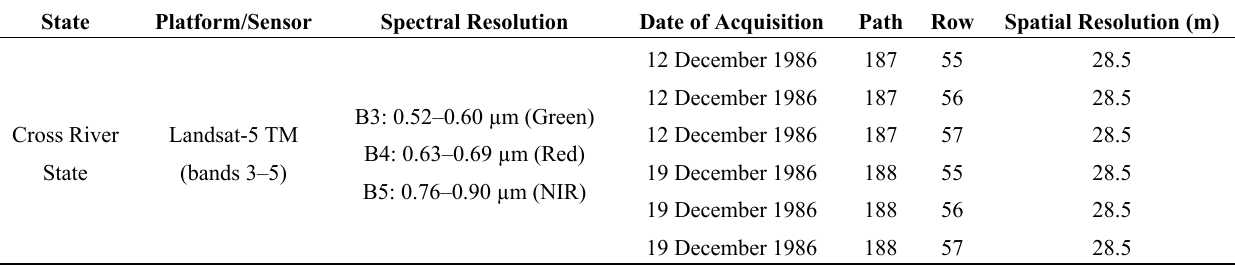
Figure 2. Methodology for remote sensing analysis. Table 1. Characteristics of space borne satellite images used in the